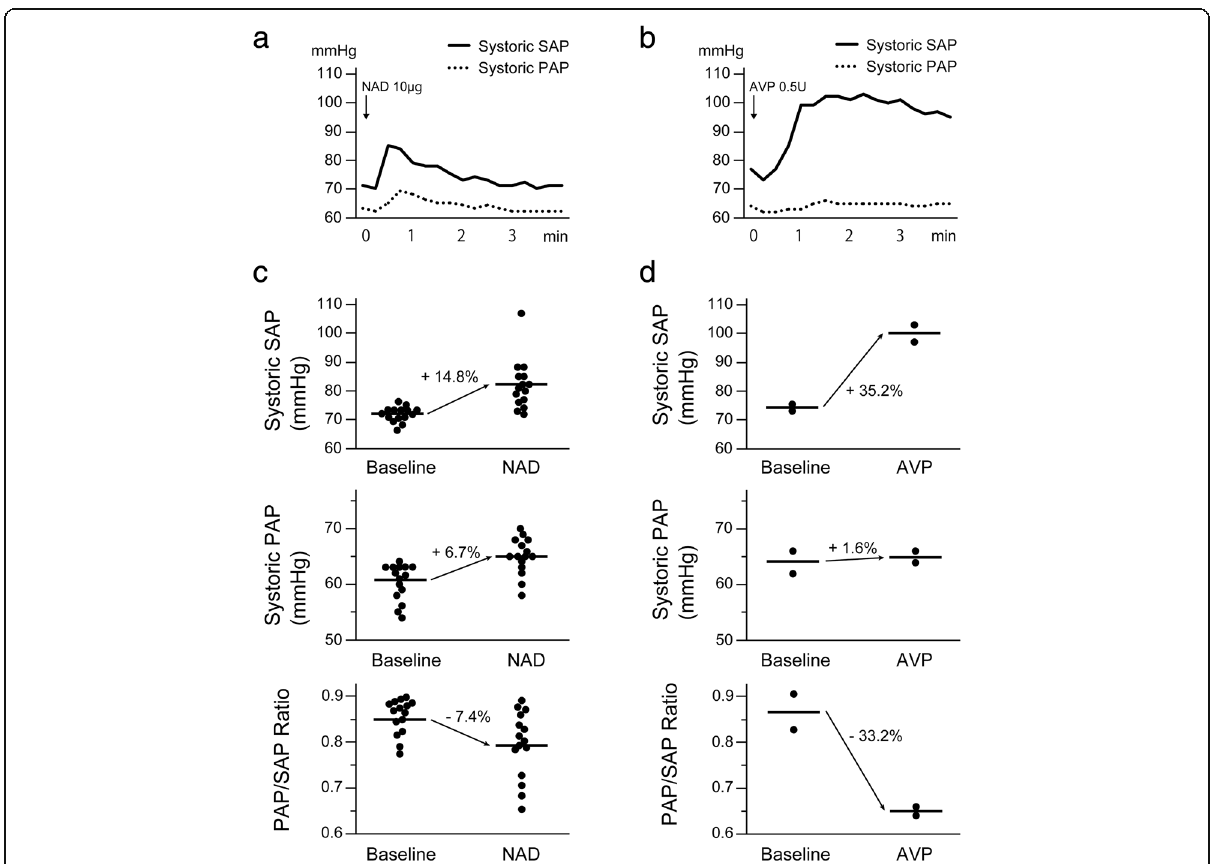
Fig. 2 Hemodynamic responses to bolus doses of NAD and AVP. a , b Representative responses of blood pressure to bolus doses of NAD ( a ) and AVP ( b ). c , d Changes in blood pressure before and after bolus doses of NAD ( c ) and AVP ( d ). Blood pressure (PAP or SAP) just before the administration of NAD or AVP was considered the baseline level. The peak blood pressures within 3 min after the administration of NAD or AVP were obtained. Horizontal lines represent mean values. NAD noradrenaline, AVP arginine vasopressin, PAP pulmonary arterial pressure, SAP systemic arterial